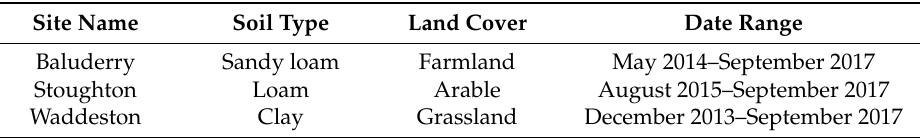
Table 1. Details of the sites used for model